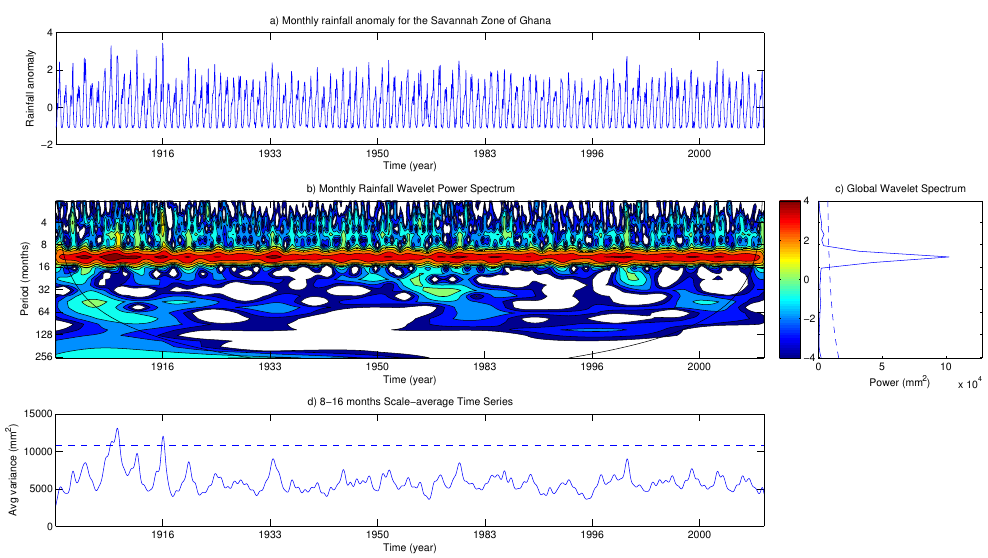
Figure 20. ( a ) Monthly Rainfall Anomaly in the Savannah Zone for the 1901–2010 period. ( b ) Wavelet Power Spectrum for the Savannah Zone. Cross-hatched region is the cone of influence. ( c ) The global wavelet power spectrum. The dashed line is the 5% significance level for the global wavelet spectrum; and ( d ) Scale-average wavelet power over the 8-16 months band. The dashed line is the 95%